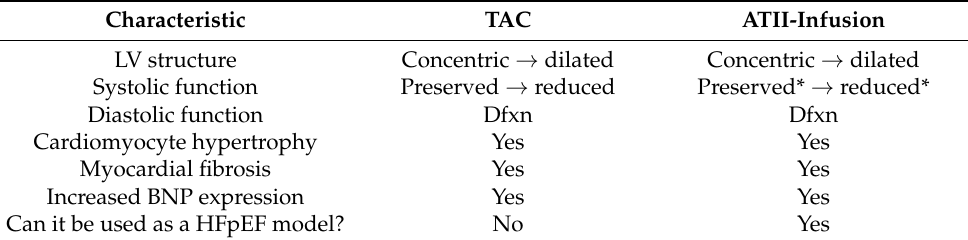
Table 1. Comparison between PO-HF murine